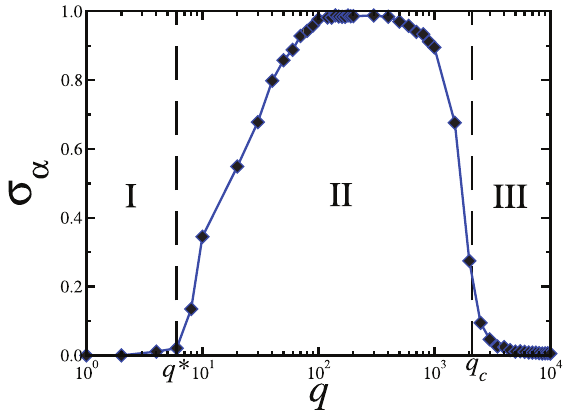
Figure 4. The quantity s a ~ (1 { P 1 ( M b )) S 1 as a function of q for a Figure 6. Normalized size of largest domain S 1 a a q = N a with fixed intensity B ~ 0 : 1 , for different population sizes: fixed value B ~ 0 : 0005 , with F ~ 10 . The critical values q (cid:3) and q c , as N a ~ 0 : 5 N (squares); N a ~ 0 : 56 N (circles); N a ~ 0 : 8 N (diamonds). well as the regions where phases I, II, and III occur, are indicated. System System size is N ~ 800 and F ~ 10 size is N ~ 800 with partition N a ~ 0 : 6 N . Each data point is averaged over 100 realizations of initial conditions.